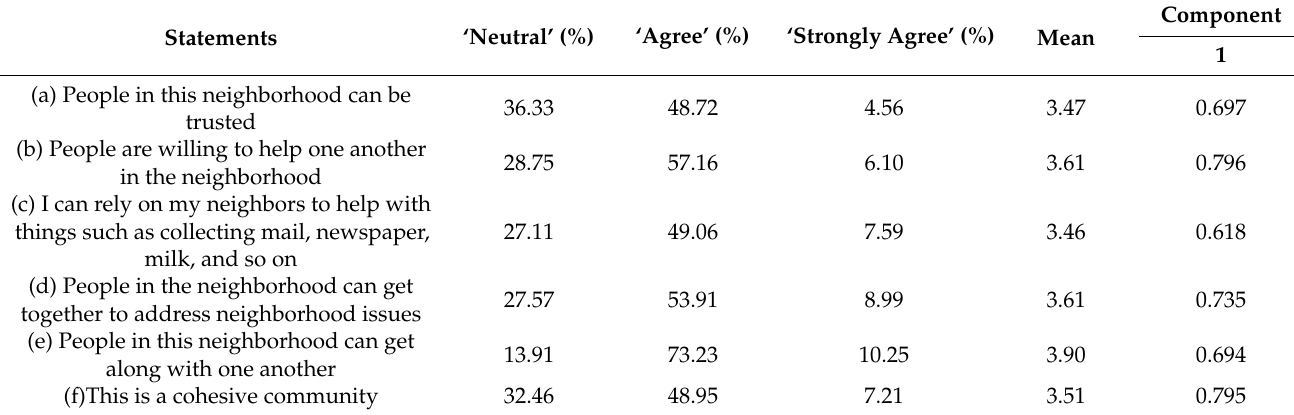
Table 1. Principal component analysis of